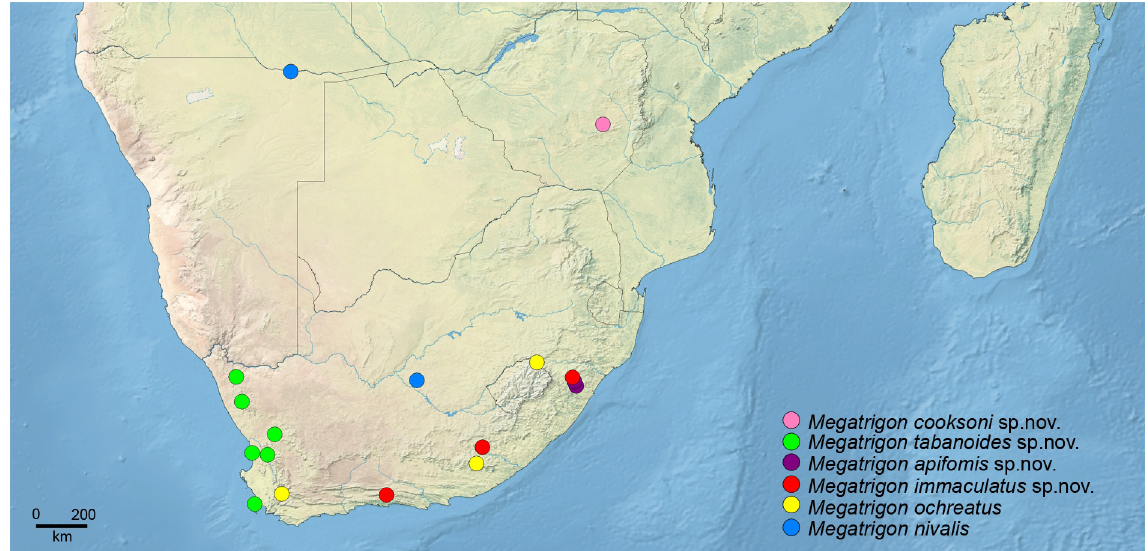
Fig. 16. Megatrigon nivalis and M. argenteus species group (subgroup 2),